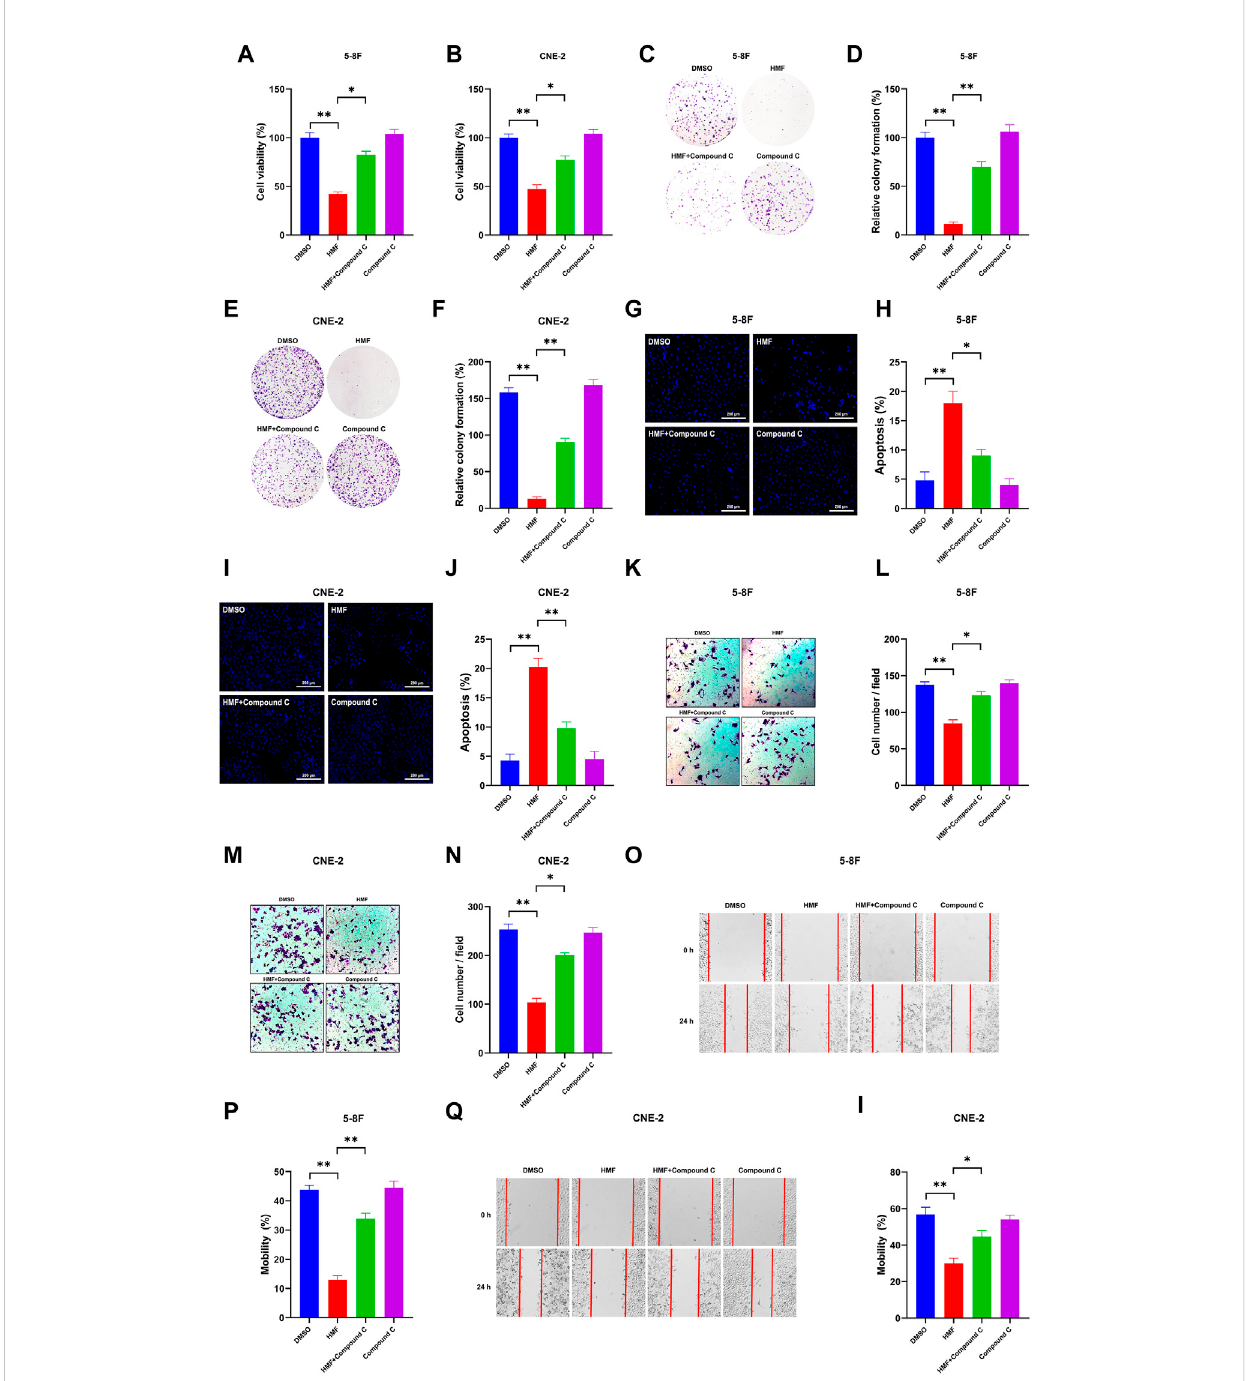
FIGURE 5 Effects of AMPK on proliferation, apoptosis, and metastasis through regulation of the AMPK-dependent signal pathway in two NPC cell lines. After high-dose HMF (50 μ M) co-treated with Compound C (AMPK inhibitor) for 24 h. (A,B) The cell viability was determined by CCK-8 assay. (C – F) The colonieswerestainedwith0.5%crystalviolet,andthecolonynumberswerequanti fi ed. (G,I) Assessmentofthemorphologicalchangesineachtreatment group using a fl uorescence microscope (20×). (H,J) Apoptosis (%) in each group. (K – N) Representative images of transwell migration assays (10×) andquanti fi cationofcellmigrationexpressedbycell counting. (O – I) Representative images ofthescratchassay (10×)andmobility(%)24 hafter thecells were scratched. All data are described as the mean ± SD of three independent and repeated experiments. Compared to the control group (0 μ M): * p < 0.05; ** p < 0.01; ns, not signi fi